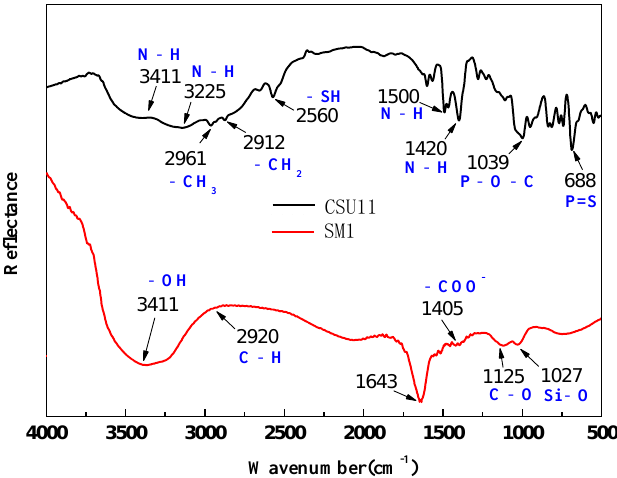
Figure 9. FT-IR spectra of the collector CSU11 and the depressant SM1 (CSU11 concentration 50 mg/L, SM1 concentration 200 mg/L).